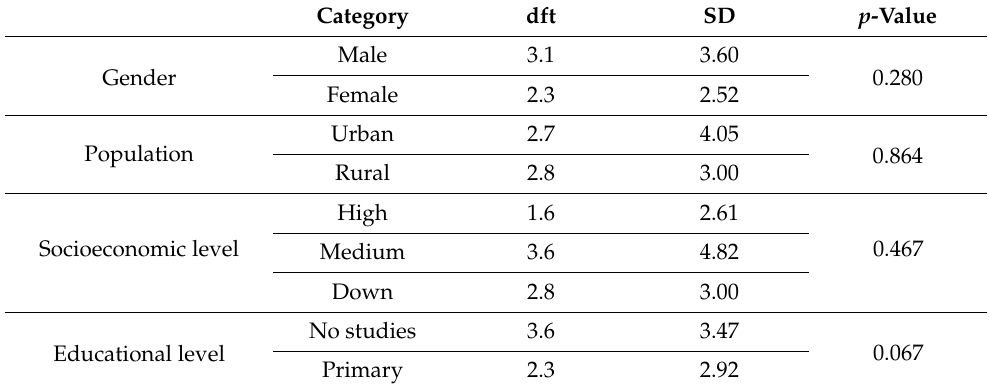
Table 8. Relationship of socio-demographic variables with the dft index. Significance for p -value < 0.05.